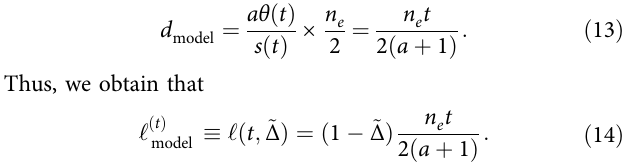
consistently. The complete set of segmented crease patterns and fi tted area distributions for all data samples is provided in Sup- plementary Figs. 1 and 2.